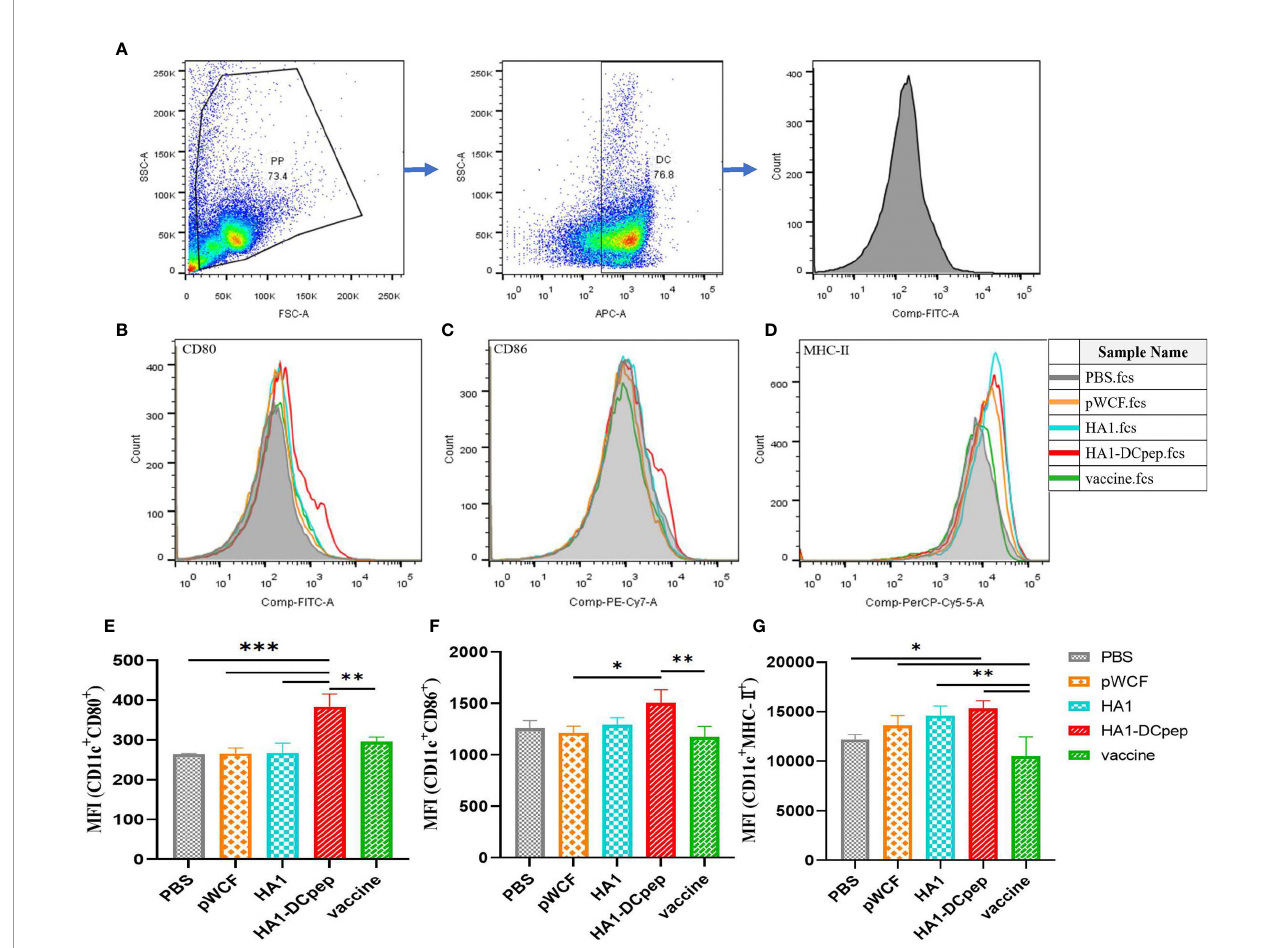
FIGURE 2 | Activation of DC costimulatory molecules by L. plantarum expressing HA1 and HA1-DCpep. After booster immunization, mice PPs were harvested, and cell suspensions was prepared using 1 ×10 6 total cells treated with anti-CD16/CD32 for molecular staining of the DC surface (A) Gating strategy for DCs in PPs. Flow cytometry was performed to detect the expression levels of CD80 (B, E) , CD86 (C, F) , and MHC-II (D, G) in DCs in PPs. Statistical signi fi cance was assessed by one-way ANOVA (n = 3 mice per group). *P < 0.05; **P < 0.01; ***P <